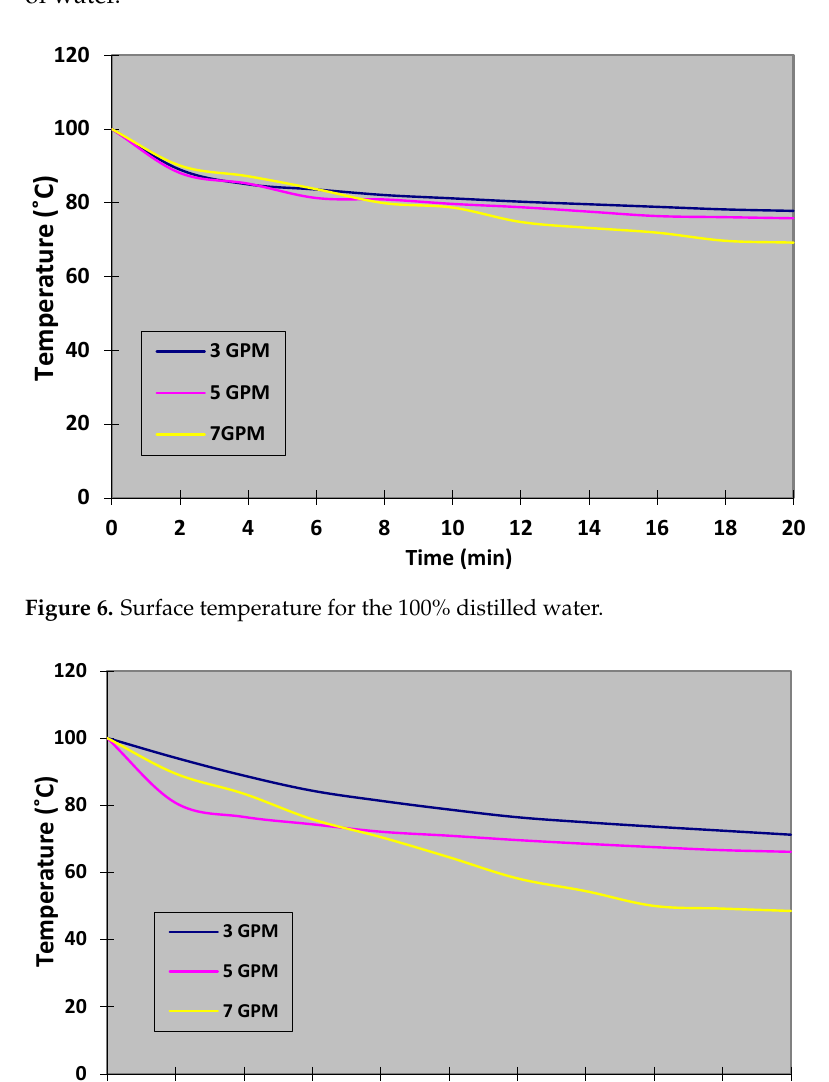
Figure 7. Surface temperature for 75% of distilled water mixed with 25% of ethylene glycol.